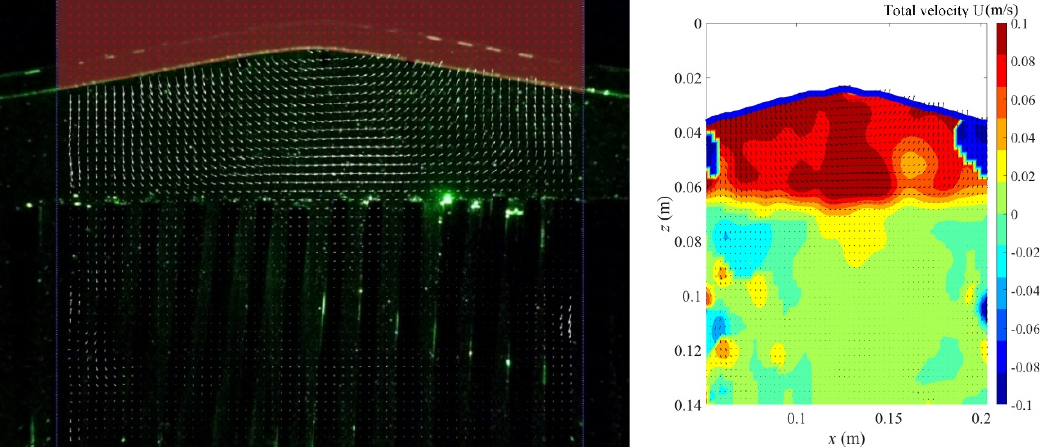
Figure 4. Velocity field and distribution of a short-period wave crest ( T = 0.5 s) passing through vegetation structures ( ϕ = 0.5 cm and d = 10 cm).